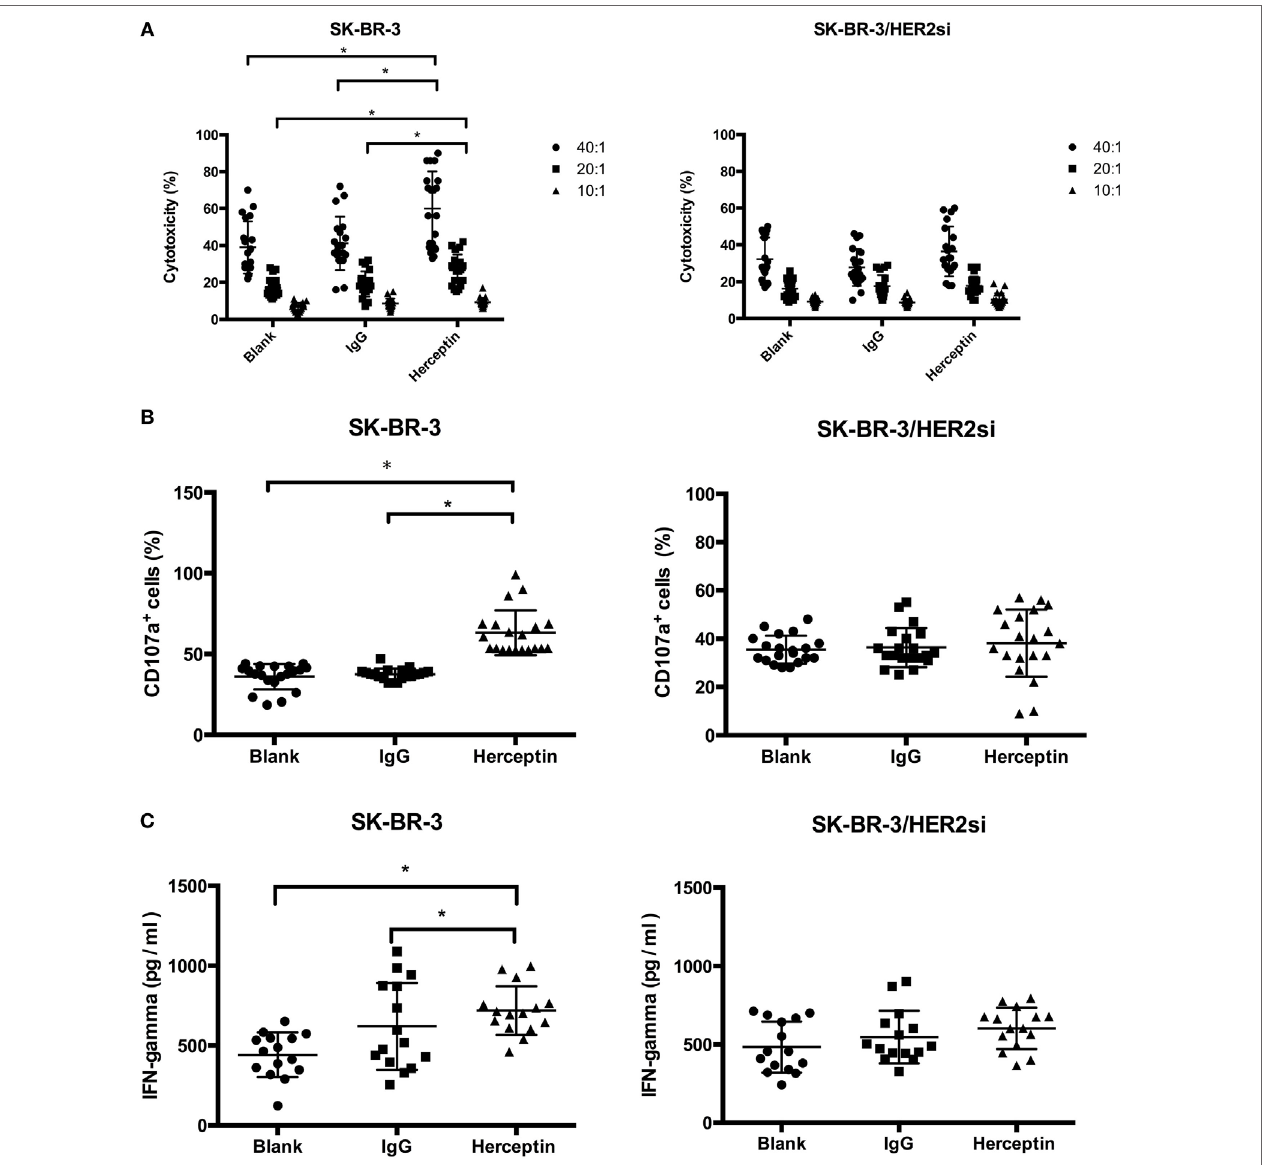
FigUre 2 | Cytotoxicity of expanded natural killer (NK) cells toward breast cancer cells. For the cytotoxicity assay, NK cells were enriched prior to the assay. (a) The cytotoxicity of expanded NK cells toward SK-BR-3 and SK-BR-3/HER2si cells was measured using the lactate dehydrogenase (LDH) release assay at 40:1, 20:1, 10:1 effector-to-target (E:T) ratios for 4 h. (B) NK cell degranulation after coculture with cancer cells. The cytotoxicity of expanded NK cells toward SK-BR-3 and SK-BR-3/HER2si cells was measured using a CD107a release assay at 40:1 effector-to-target (E:T) ratios. Differences in the frequency of CD107a + cells among NK cells in the Herceptin, IgG1 and blank groups were analyzed for statistical significance. (c) The level of interferon (IFN)- γ secretion after coculture with cancer cells. NK cells were stimulated with the indicated targets, SK-BR-3 and SK-BR-3/HER2si cells. After 3 days, supernatants were collected and IFN- γ levels were measured. The results are presented as the means of 15 patients and error bars represent the SD. * p <